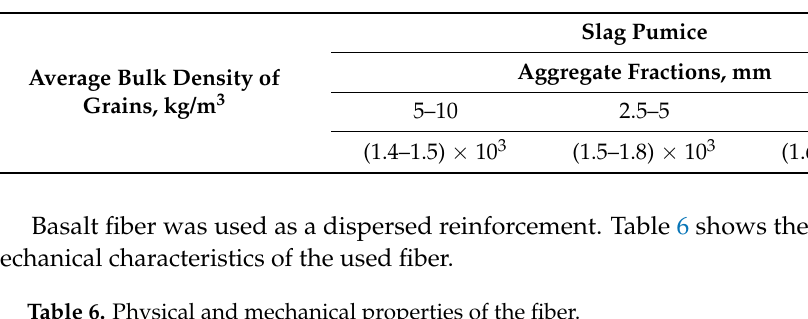
Table 5. Density limits of grains for combined mixtures.